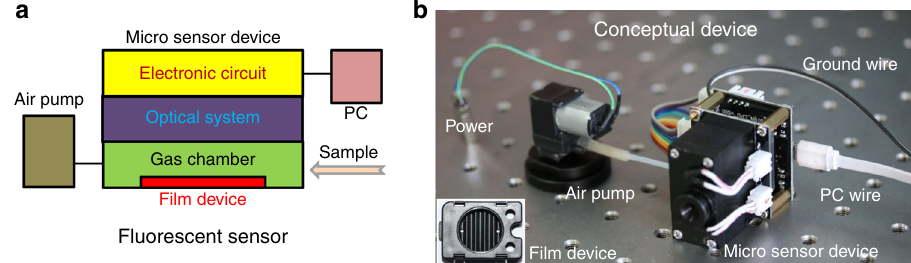
Fig. 4 Fluorescent sensors and sensing platform. a Schematic representation of a fl uorescent sensor. b One-sensor-based sensing platform for evaluation of sensing properties of fl uorescent fi lms